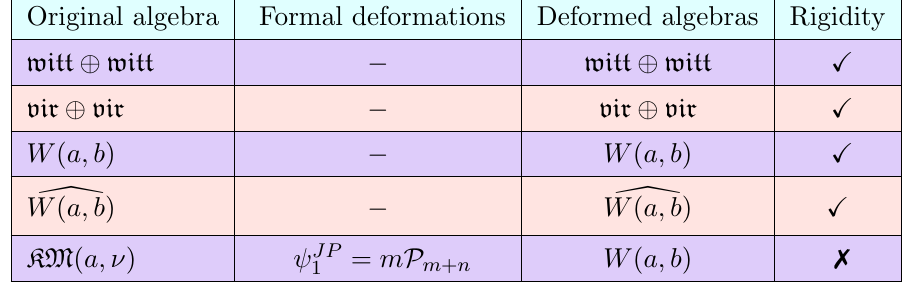
and bms 3 , the u (1)